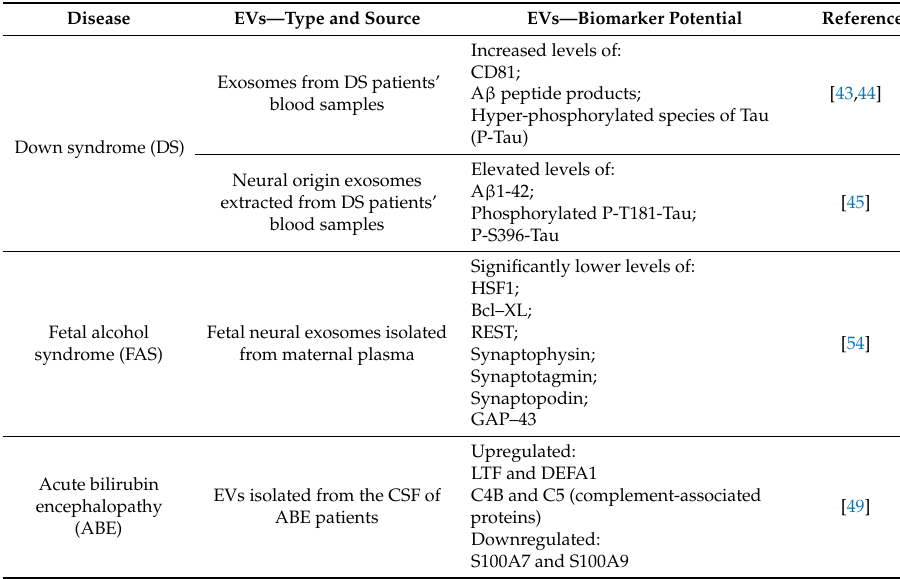
Table 3. EVs as potential biomarkers for neurodevelopment-related